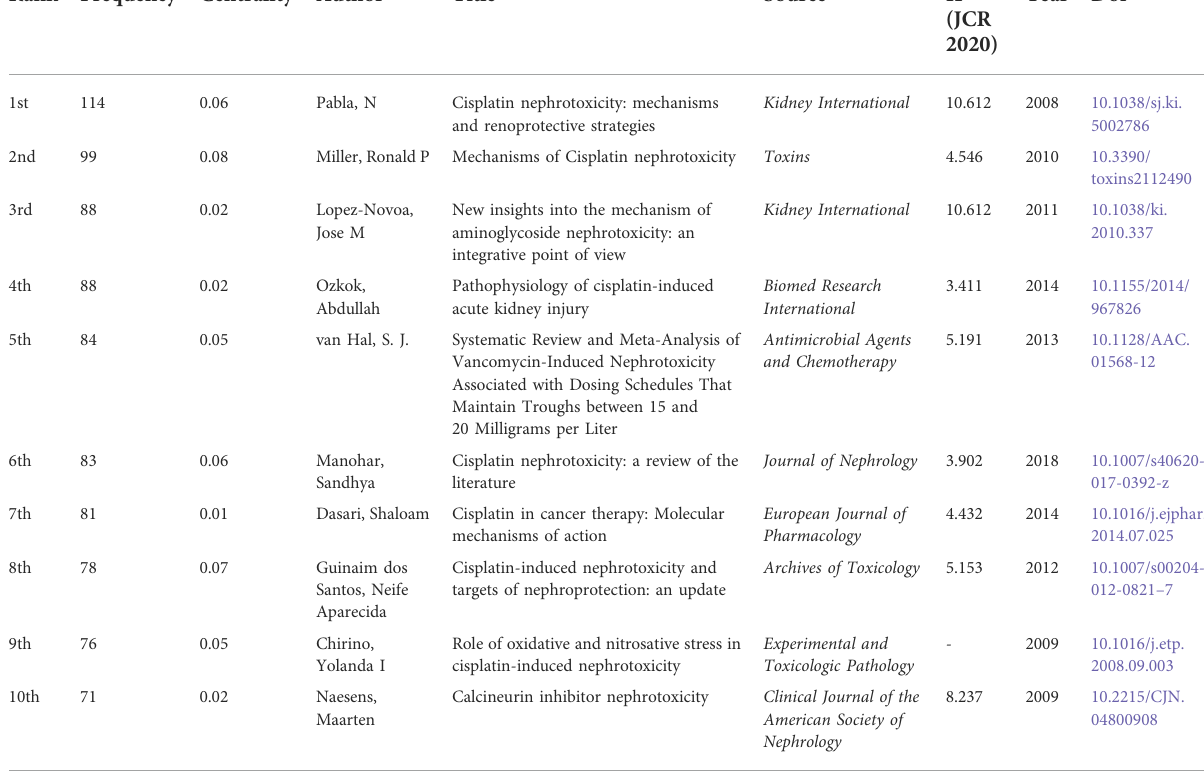
TABLE 4 Top 10 co-citation references in nephrotoxicity